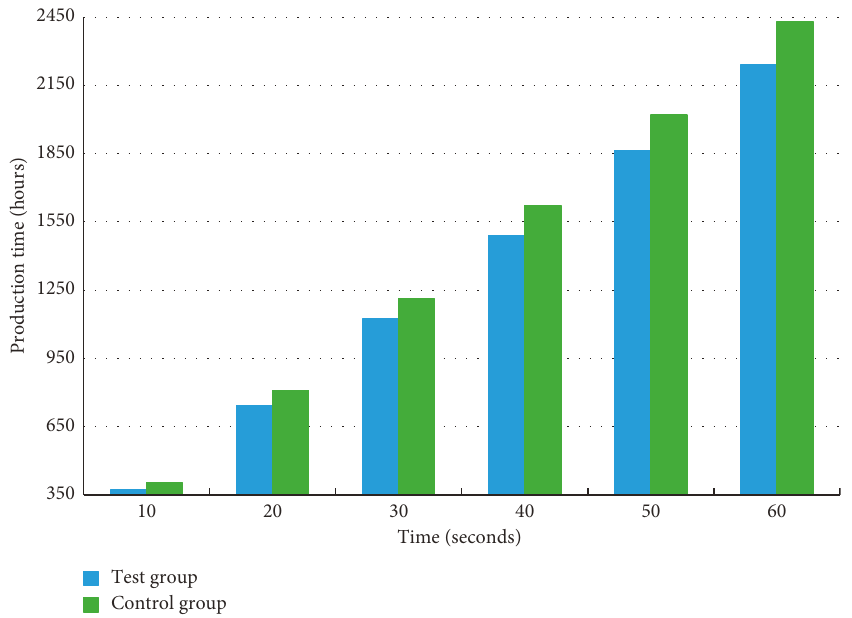
Figure 11: Comparison of production time of two special effects